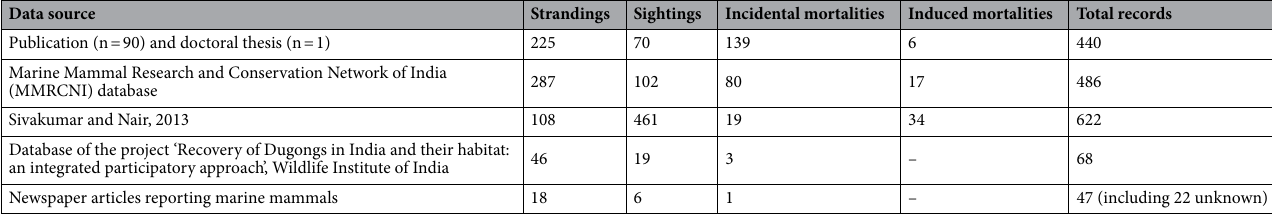
Table 3. Data sources, types of events and total number of records for each event for marine mammals in Indian waters compiled for a period from